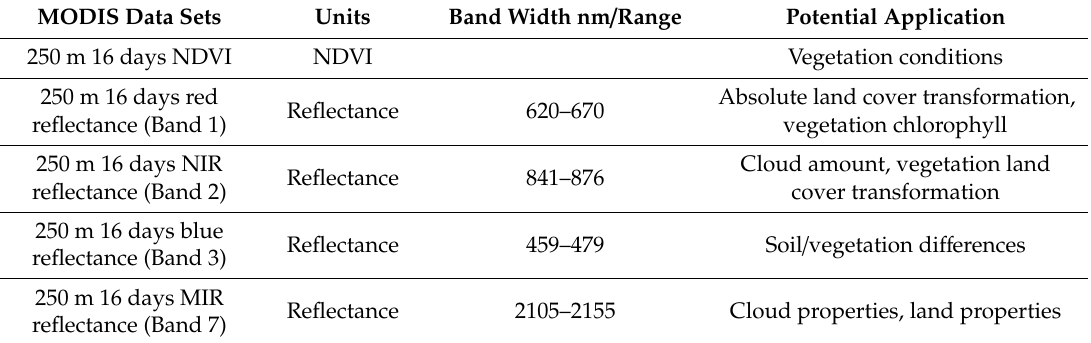
Table 1. Characteristics of satellite data used in this